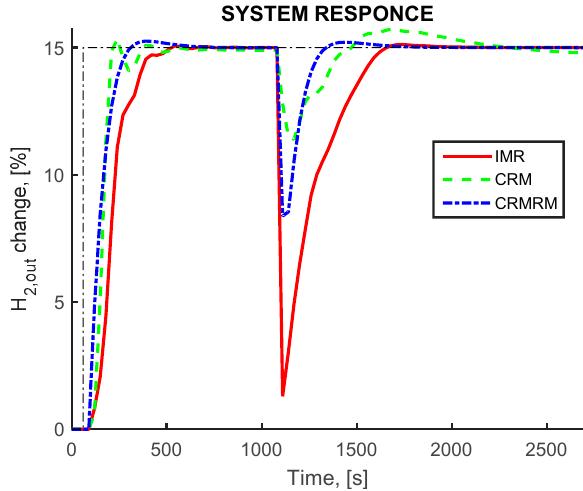
Figure 9. Pure hydrogen production rate (controlled variable). IMR (red continuous curve), CRM (green dashed curve), and CRMRM flowsheet (blue dashed-dot curve). Setpoint change for hydrogen production at 150 s and disturbance influence at 1000 s.